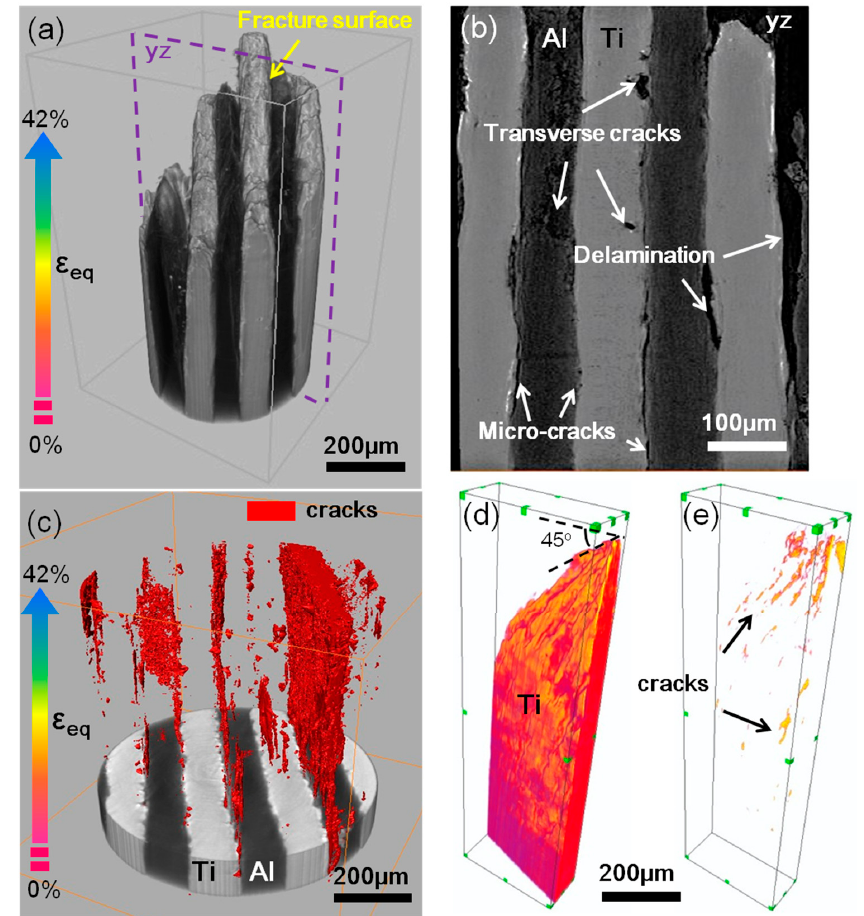
Figure 6. Reconstructed crack morphology of the fractured LMC sample [12]: ( a ) 3D morphology of fractured LMC; ( b ) 2D tomographic slice in the fracture of LMC; ( c ) crack distribution under increased equivalent strain; and ( d , e ) the rapid crack nucleation and propagation near the fracture of abstracted Ti